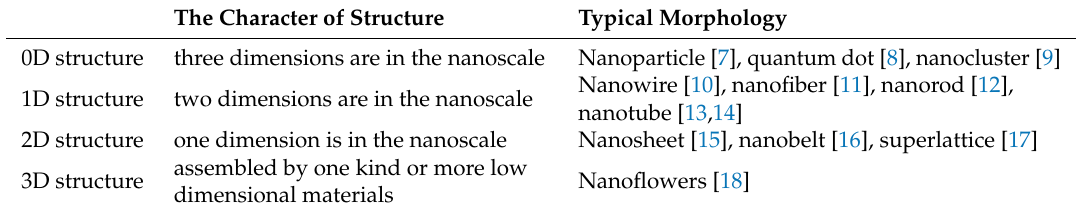
Table 2. The classification of nanostructures and typical